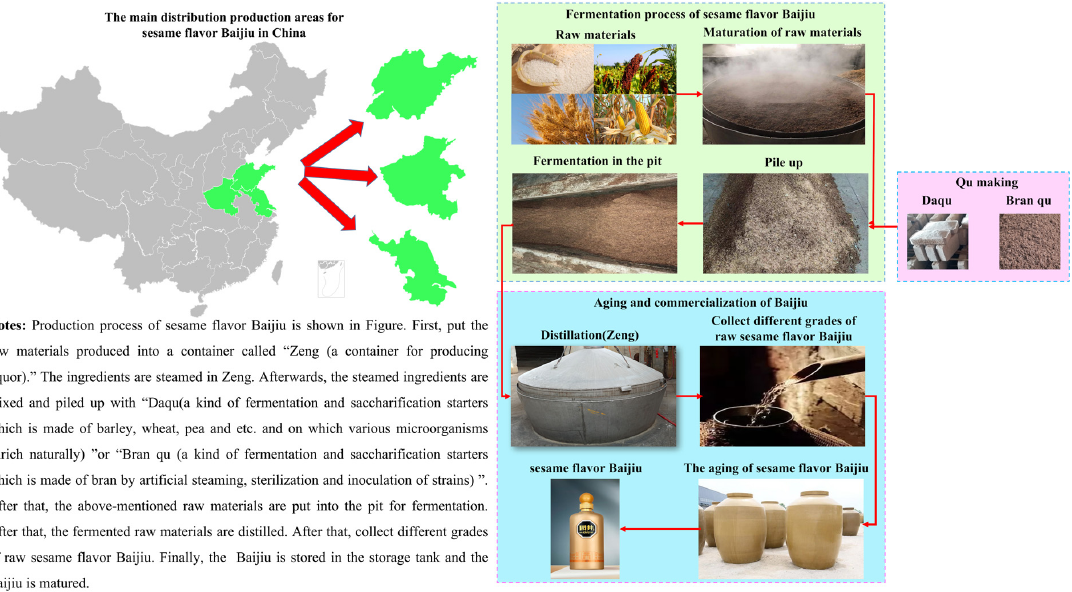
Figure 2. Production process of sesame flavor Baijiu.